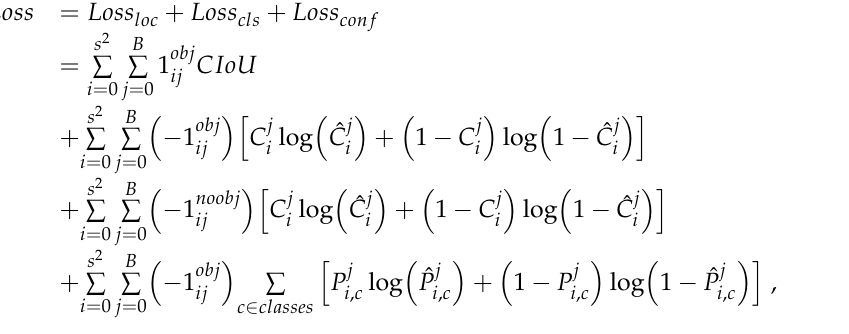
Figure 5. Network architecture of the designed model.